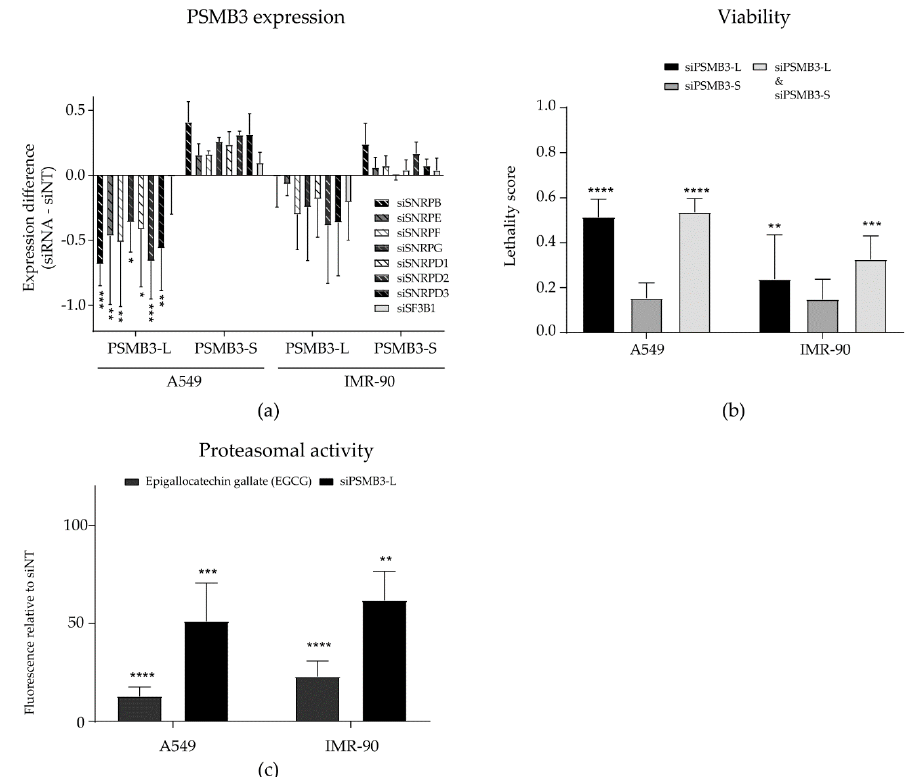
Figure 3. Sm gene silencing induces a cytotoxic alternative splicing switch in PSMB3 more abundantly in non-small cell lung cancer (NSCLC) cells than in non-malignant cells. ( a ) PSMB3 expression was assessed upon silencing all seven Sm genes in A549 NSCLC cells and non-malignant IMR-90 lung fibroblasts. The knockdown of Sm genes led to a significant decrease in PSMB3-L expression in A549 NSCLC cells only. A trend of increased PSMB3-S expression was also observed in these cells, however, this was not significant. In non-malignant IMR-90 lung fibroblasts, a trend of decreased and increased expression of PSMB3-L and PSMB3-S, respectively, was also observed, but this was not significant and to a far lesser extent than observed for A549 NSCLC cells. ( b ) The silencing of PSMB3-L, but not PSMB-S, decreased cell viability in both A549 NSCLC cells and IMR-90 non-malignant lung fibroblasts and was accompanied by decreased proteasomal activity, as measured by N-Succinyl-Leu-Leu-Val-Tyr-7-Amido-4-Methylcoumarin (suc-LLVY-AMC) cleavage ( c ). Error bars indicate the standard deviation. * p < 0.05; ** p < 0.01; *** p < 0.001; **** p <